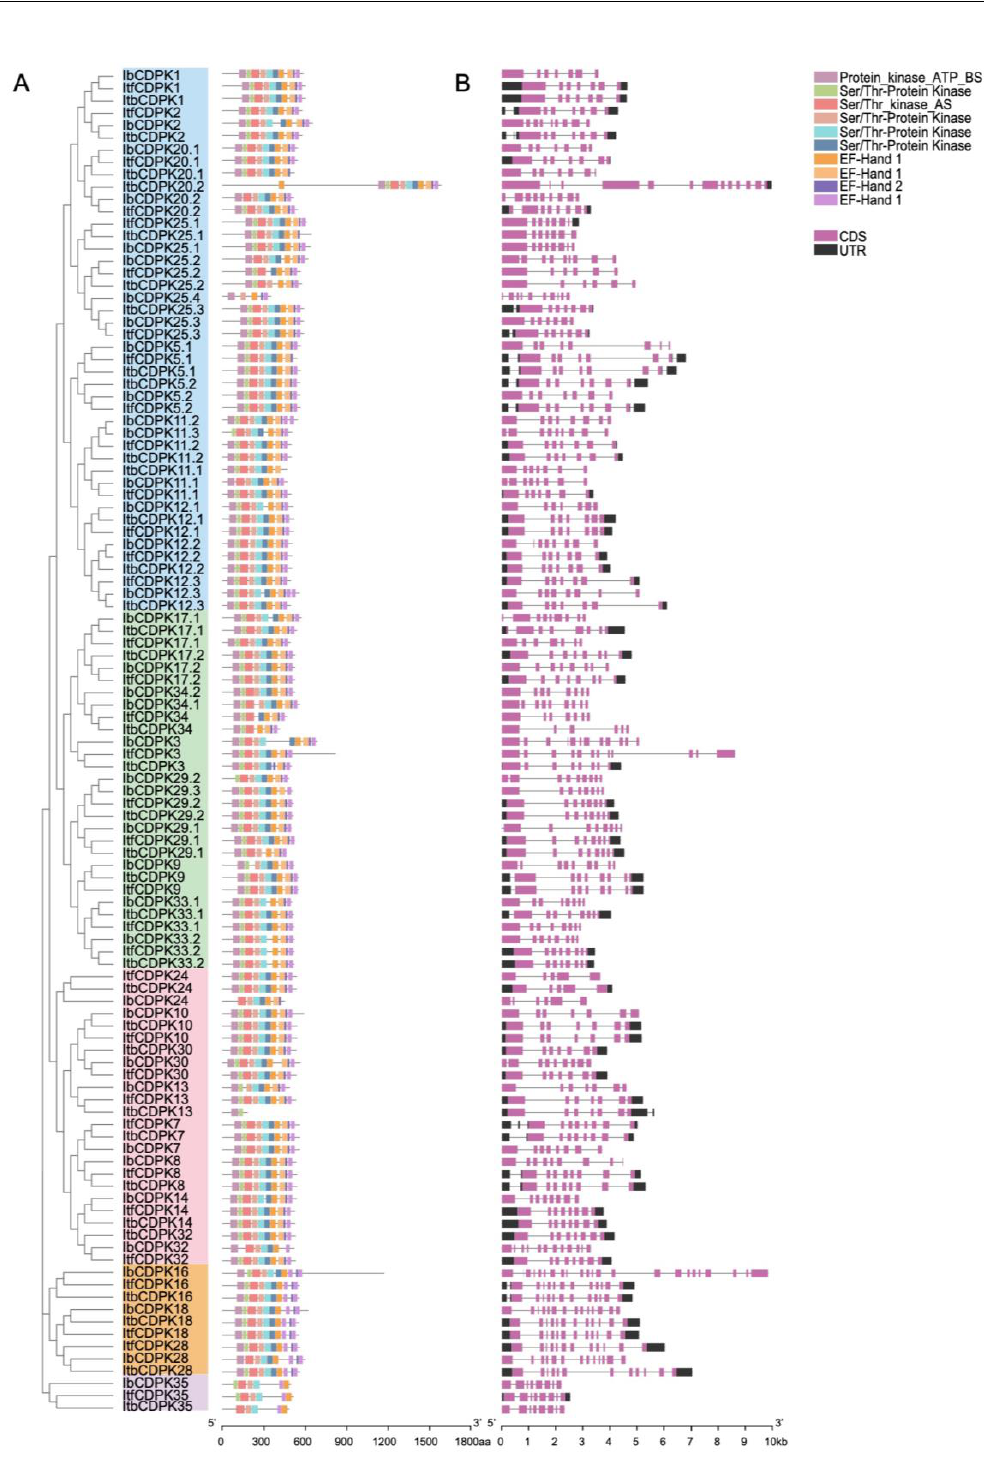
Figure 3. Conserved motifs and exon–intro structure analysis of IbCDPKs, ItfCDPKs , and ItbCDPKs family. ( A ) Ten conserved motifs of CDPKs are shown in different colors. ( B ) Exon–intron structures of IbCDPKs, ItfCDPKs , and ItbCDPKs . The purple boxes, black boxes, and black lines represent the CDS, UTRs, and introns, respectively.